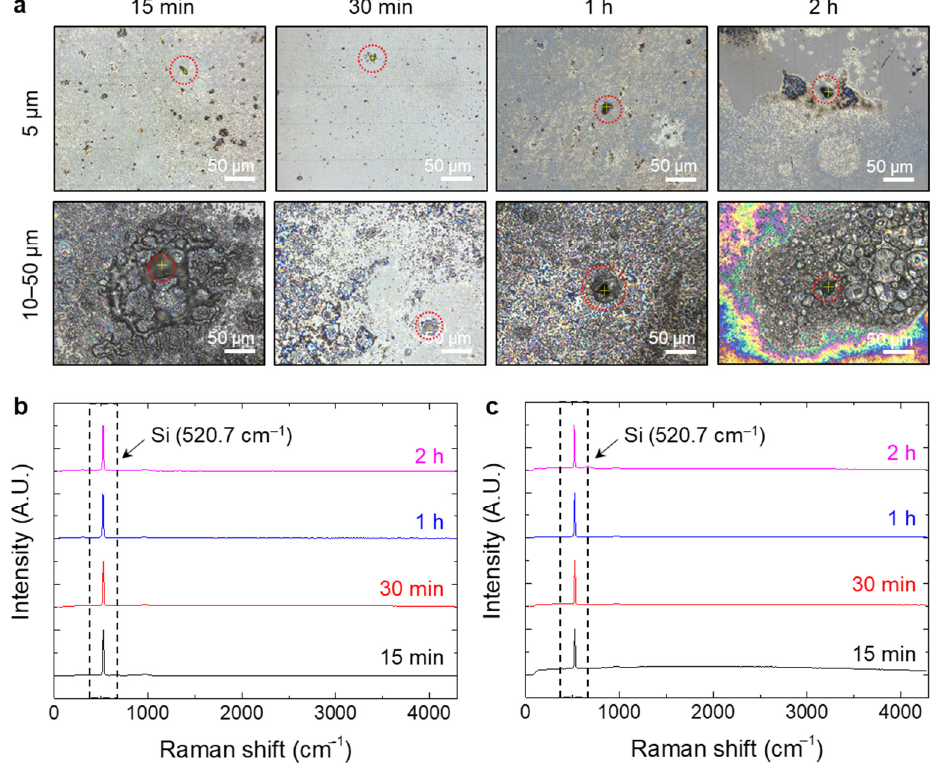
Figure 6. Detection of PTFE microplastics in whole blood. ( a ) Microscopic images of microparticles captured on silicon filters from blood collected at 15, 30, 60, and 120 min after oral administration of PTFE microplastics (approximately 5 and 10‒50 μm). ( b , c ) PTFE microplastics were not detected on filters. Silicon (Si) peaks are indicated by the arrow. Scale bar = 50 μm.